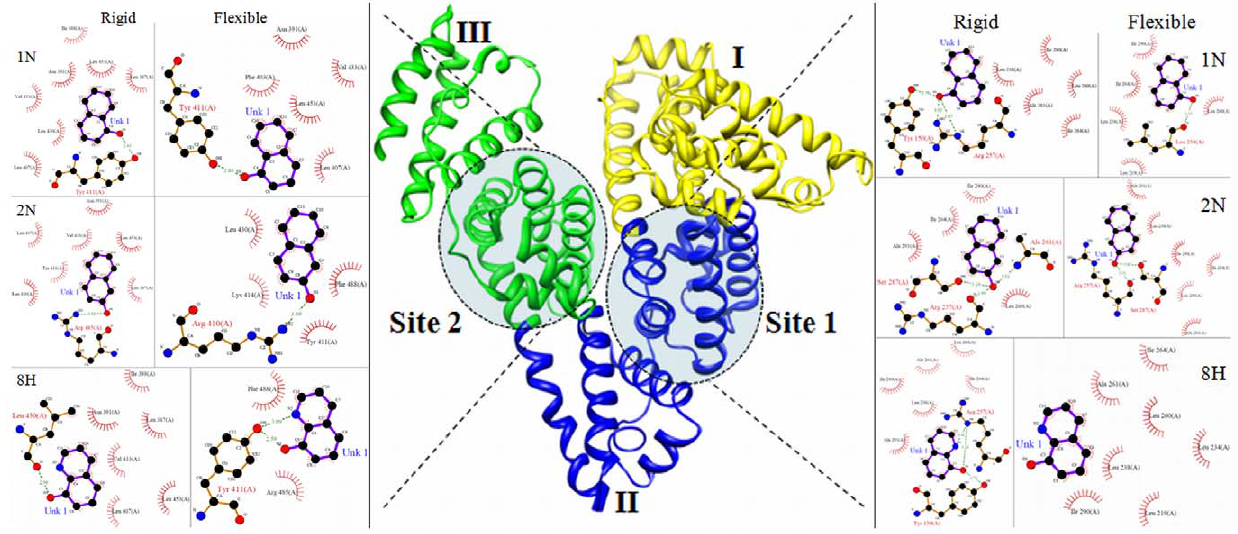
Figure 13. Molecular contacts between the amino acid residues of site 1 (right side) and site 2 (left side) of HSA and pollutants (1N, 2N and 8H) within 5 A˚. Obtained from rigid and flexible docking by AutoDock4 are shown in the form of LigPlot.